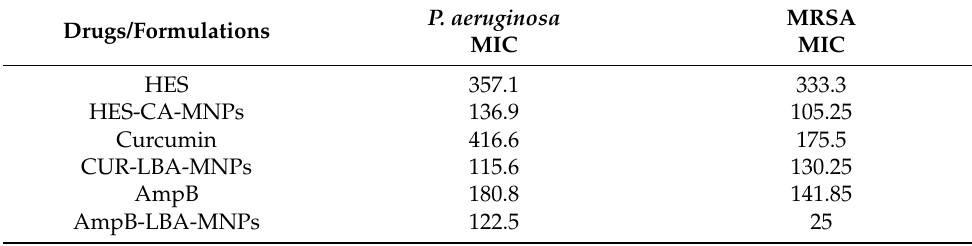
Table 3. Minimum inhibitory concentration (MIC) of drugs and drug-loaded NPs (µg/mL).